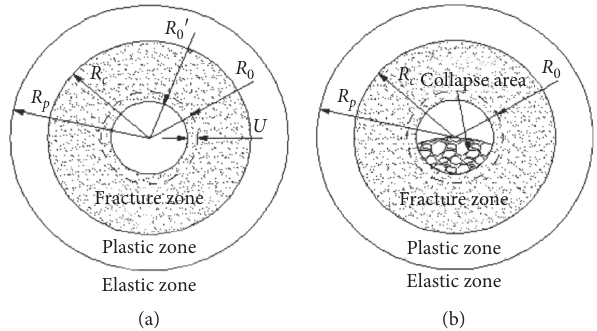
Figure 1: Sketch map of unstable deformation area of coal seam around borehole. (a) Before the borehole collapses. (b) After the borehole collapses. R 0 , borehole radius before instability; R c , radius of fracture zone; R p , radius of plastic zone; R radial deformation of coal body.